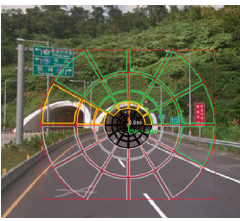
Figure 4: L seq evaluation diagram of the trial tunnel.